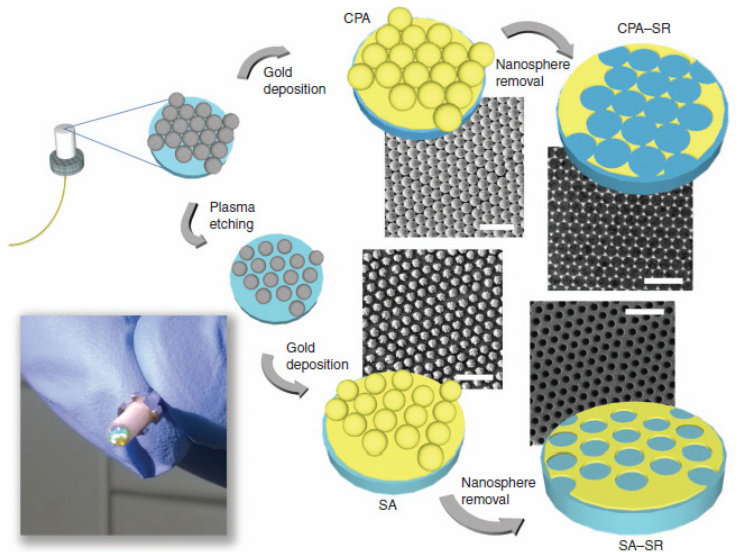
Figure 21. Schematic representation for the fabrication of the different fiber tips nanoprobes and the resultant SEM images (scale bar of 3 µm). Reprinted with permission of [84].